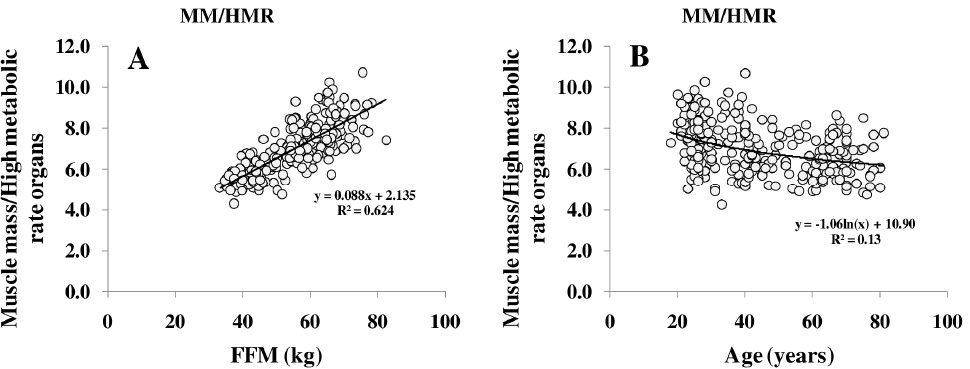
Figure 1. Age ‐ dependent decrease in fat free mass (FFM) ‐ resting energy expenditure (REE) relationship ( A ) and their residuals in different age groups (median; 95% CI) ( B ). Significant differences between age ‐ groups are indicated by # as tested by Kruskal ‐ Wallis ‐ test ( n = 714). FFM was assessed by Air Displacement Plethysmography (ADP) (for details, see Methods).